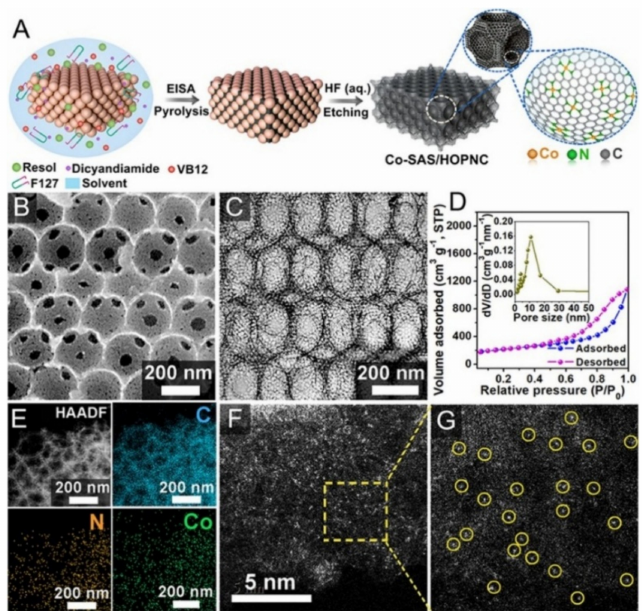
Figure 2. Fabrication of Co-SAS/HOPNC catalyst. ( A ) Step-wise synthesis procedure of Co- SAS/HOPNC. ( B ) SEM image, and ( C ) TEM micrograph of Co-SAS/HOPNC catalyst. ( D ) N 2 adsorption–desorption isotherm curves of Co-SAS/HOPNC catalyst. ( Inset ) The pore size distribu- tion curve. ( E ) HAADF-STEM micrograph and the EDS maps of Co-SAS/HOPNC catalyst. ( F , G ) AC HAADF-STEM micrographs of the Co-SAS/HOPNC catalyst. Yellow circles represent the isolated single Co atoms. Reproduced from [119], with permission from PNAS,